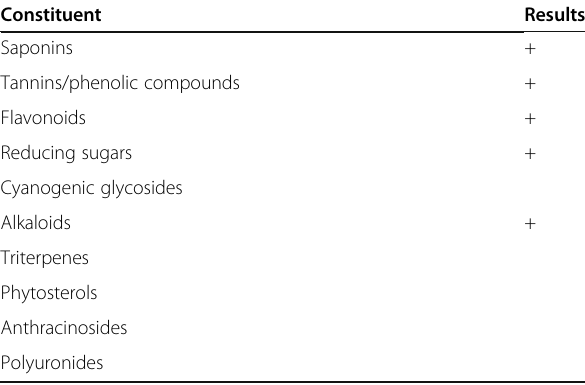
Table 1 Phytochemical components of aqueous leaf extract of Anacardium